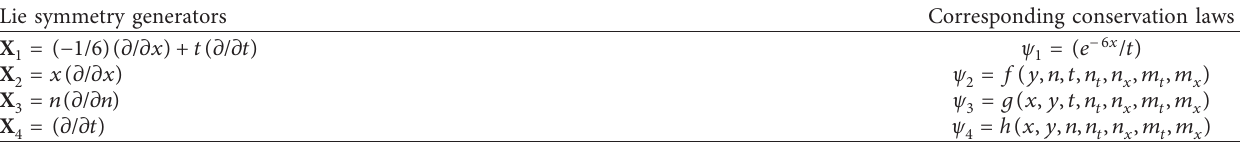
Table 7: Lie symmetry generators and corresponding conservation laws.